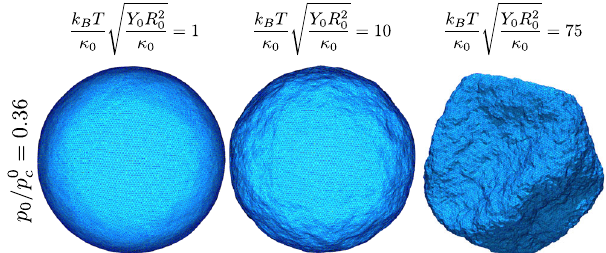
FIG. 1. Snapshots of thermalized spheres from Monte Carlo simulations under inward external pressure p 0 at 36% of the classical buckling pressure p 0 at varying temperatures T . All c three snapshots are for identical amorphous spherical shells with size R 0 ¼ 55 a ( a is the average mesh size) with bending rigidity 50 ϵ and Young ’ s modulus Y 577 ϵ =a 2 ( ϵ sets the energy κ 0 ¼ 0 ¼ scale); the Föppl – von Karman number characterizing the non- linear shell mechanics is γ ¼ Y 0 R 2 0 = κ 0 ≈ 35 ; 000 . Shells are under the same inward external pressure p 0 ¼ 0 . 08 ϵ =a 3 , but they are at T ¼ 0 . 267 ϵ , k T ¼ 2 . 67 ϵ , and k T ¼ different temperatures k B B B 20 ϵ (from left to right). Note that the shell on the right is crushed even though the inward external pressure p 0 ≈ 0 . 36 p 0 is much ffiffiffiffiffiffiffiffiffiffi c p 4 κ =R 2 0 . lower than the classical buckling pressure p 0 0 Y 0 c ¼ Images are courtesy of Gerrit Vliegenthart and details of simulations are provided in Ref.